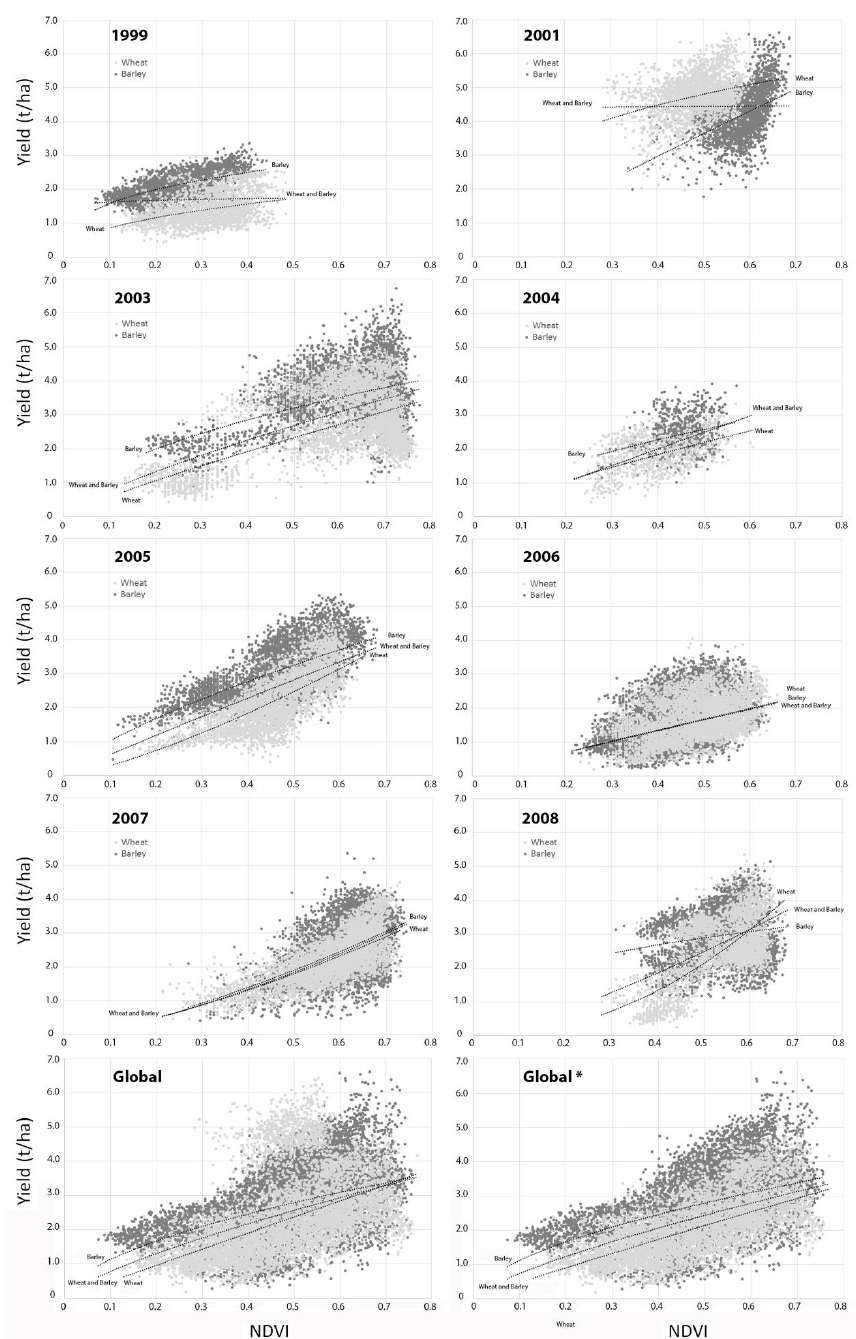
Figure 2. Wheat and barley yield vs. NDVI scatter graphs and fitted empirical power models for the eight years in the YPA and the two global models (Global* excludes the 2001 wheat yield and NDVI data).